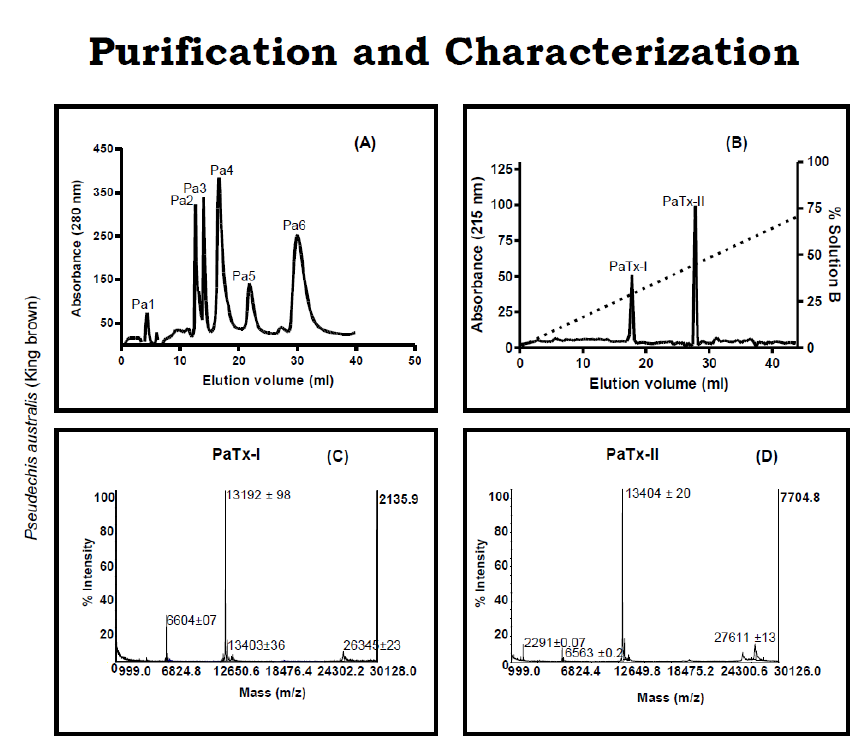
Figure 1. Purification and characterization of snake venom proteins. ( A ) Six fractions (Pa1–Pa6) were separated from the crude venom of P. australis (king brown) by a Superdex G-75 column equilibrated with 50 mM Tris-HCL buffer (pH 7.4). ( B ) The fractions (Pa4) containing antibacterial and PLA 2 activities were further purified by reverse-phase (RP)-HPLC on C18 and resolved into six peaks (Pa-F1 to Pa-F6). The most active peak (Pa-F2) was further separated on a C8 column, producing two pure proteins, PaTx-I and PaTx-II. ( C , D ) Molecular weights of the svPLA 2 proteins (PaTx-I and PaTx-II) were determined using MALDI-TOF/MS.